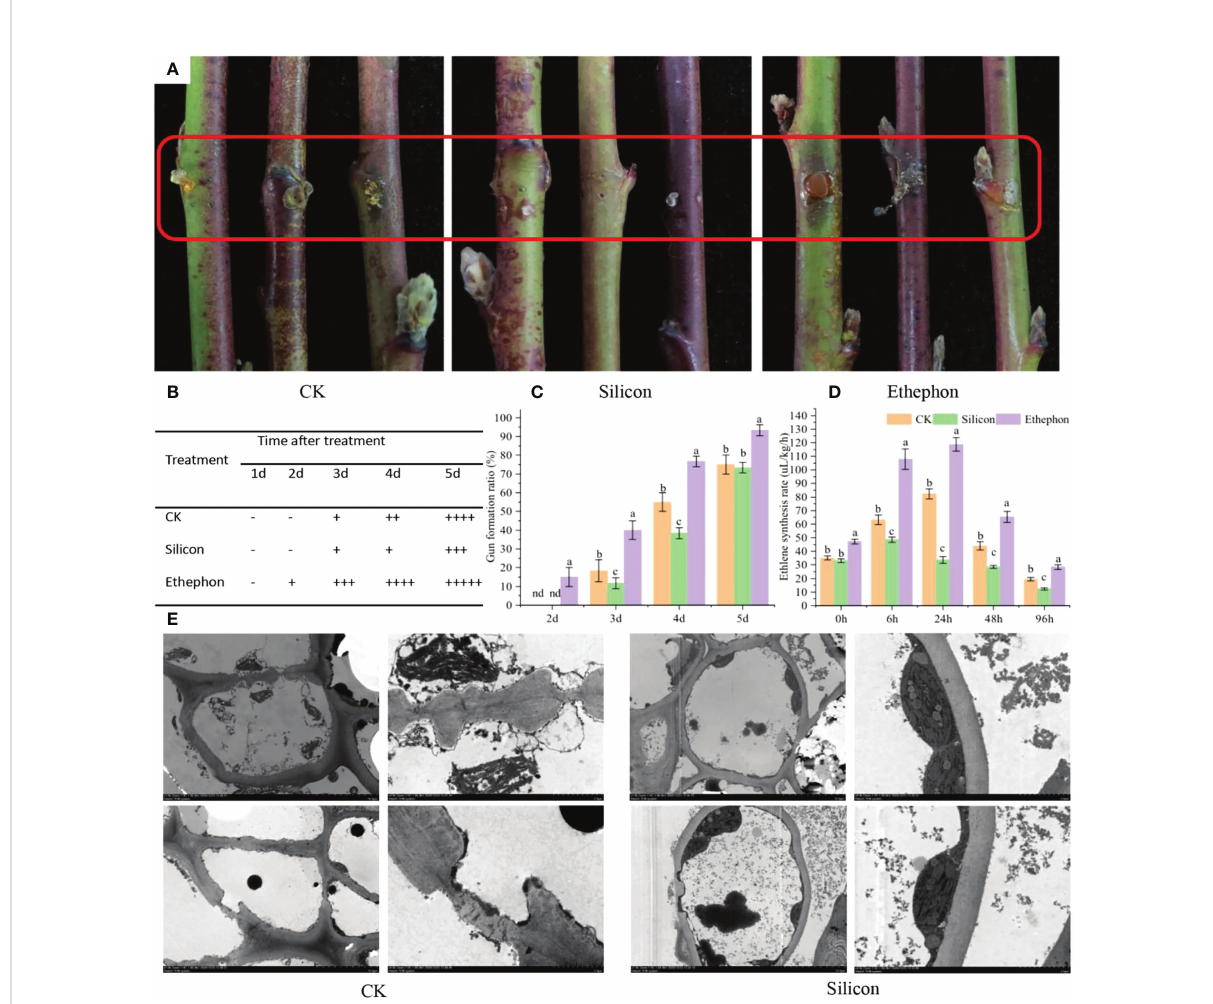
FIGURE 1 Silicon inhibits gum formation in peach shoots. (A) Photograph of gum formation in peach shoots treated with silicon (0.6 mmol/L) or ethephon (1%, w/w) after 5 days. (B) Gum formation score of shoots treated with silicon or ethephon after 5 days. The relative levels of gum production were graded based on visual observation, and the scores were as follows: − no gum; + to ++++, increasing degrees (amounts) of gum production (+, trace; ++++, high). (C) Gum formation rates of peach shoots treated with silicon or ethephon. (D) Ethylene synthesis rate of shoots treated with silicon or ethephon. (E) Electron microscopy image of the cell structure after treatment with water and silicon for 5 days (the picture on the right is the marked position of the picture on the left). Data represent the means of three replicates ± SEs, and different letters indicate signi fi cant differences (P <